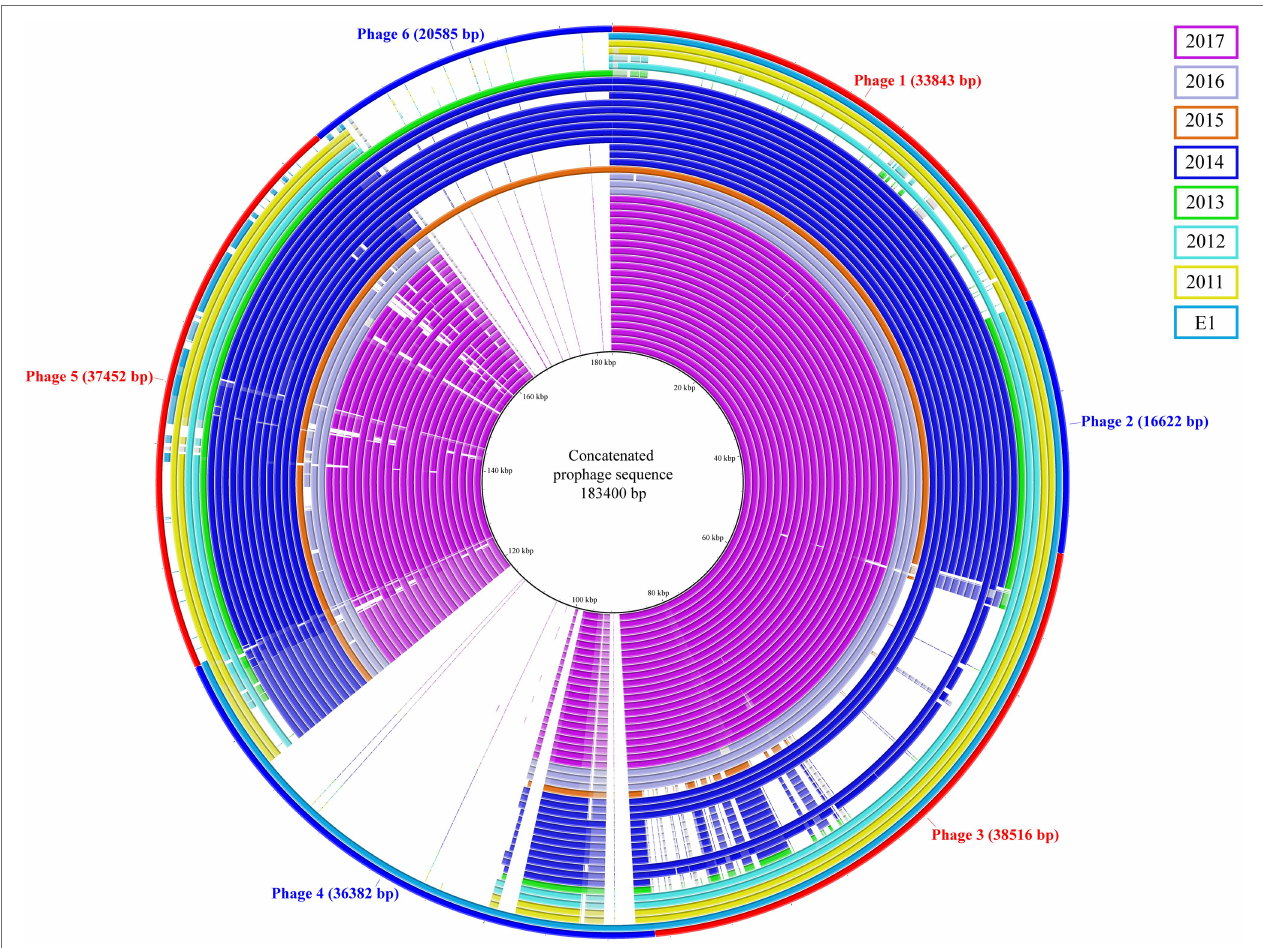
FIGURE 2 | Concatenated prophage sequences identified in ST117/CT24 isolates. The concatenated reference sequence is indicated as the red-blue outer circle, and the inner circles represent the ST117/CT24 isolates coloured by the year in which they were